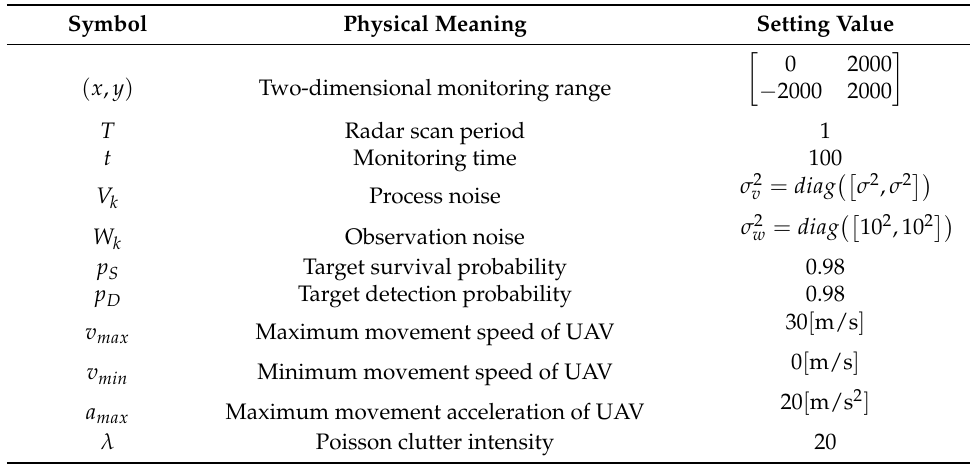
Table 1. MATLAB simulation parameter settings.